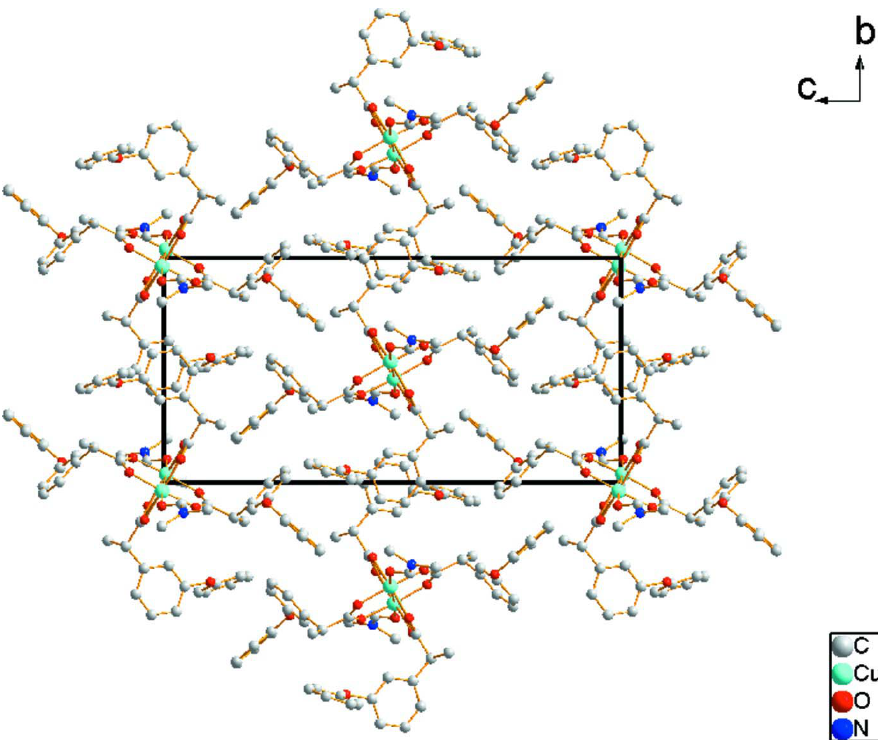
Figure 2 A view of the packing scheme, normal to the [100]